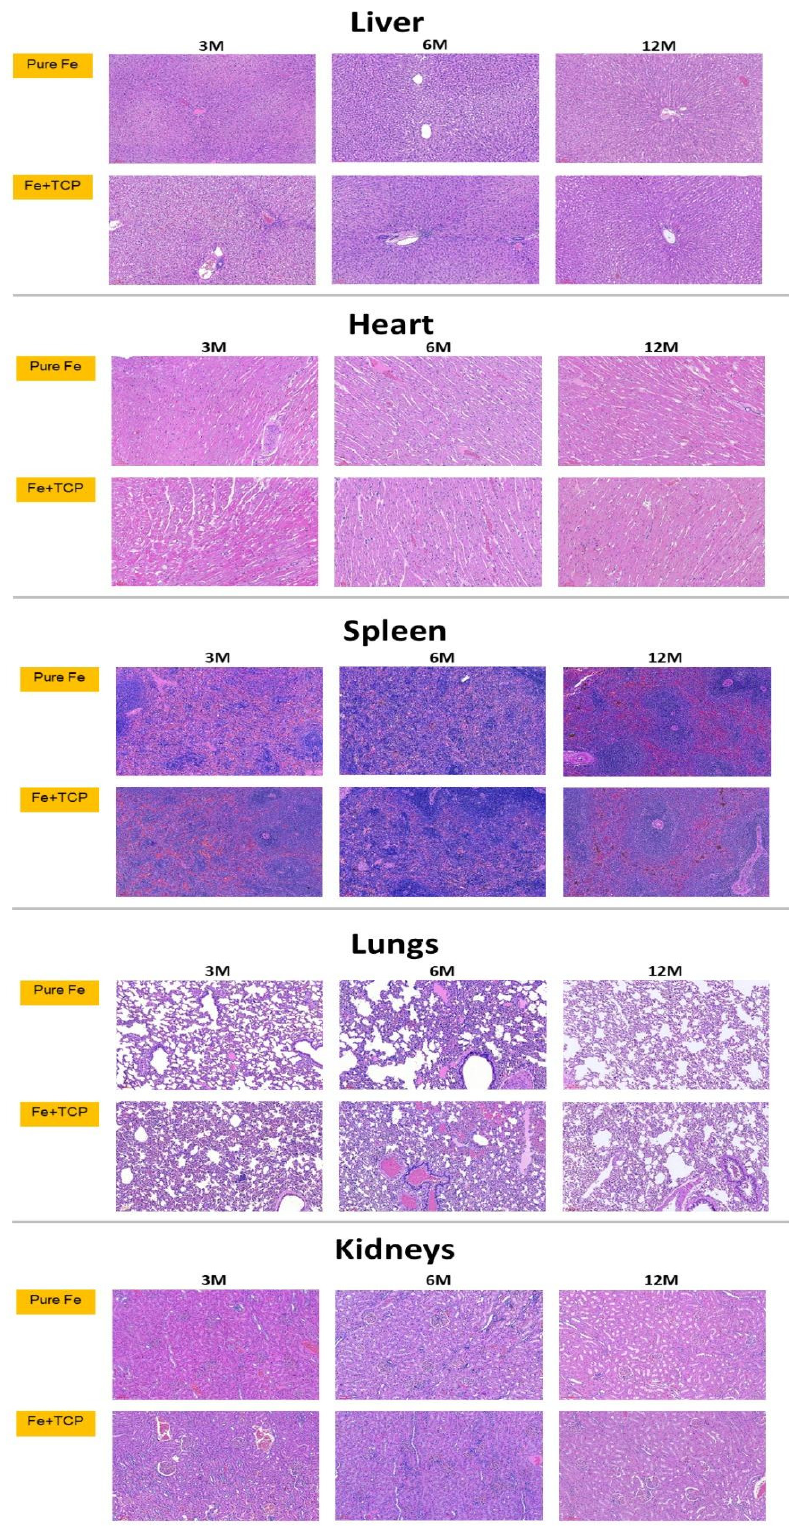
Figure 8. Histopathological specimens of visceral organs (liver, heart, spleen, lungs, and kidneys) obtained from the experimental groups at post-implantation months 3, 6, and 12. The liver, heart, lungs, and kidneys appeared to be normal, without visible pathological lesions during the entire study period. However, significant Fe deposition was noted in the spleen over time. Magnification, 100×.